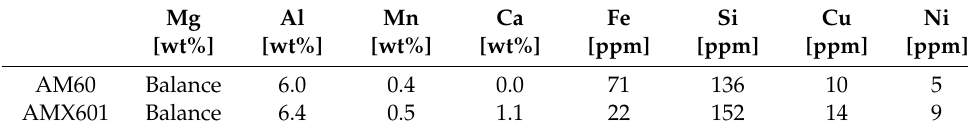
Table 1. The chemical composition of extruded AM60 and AMX601